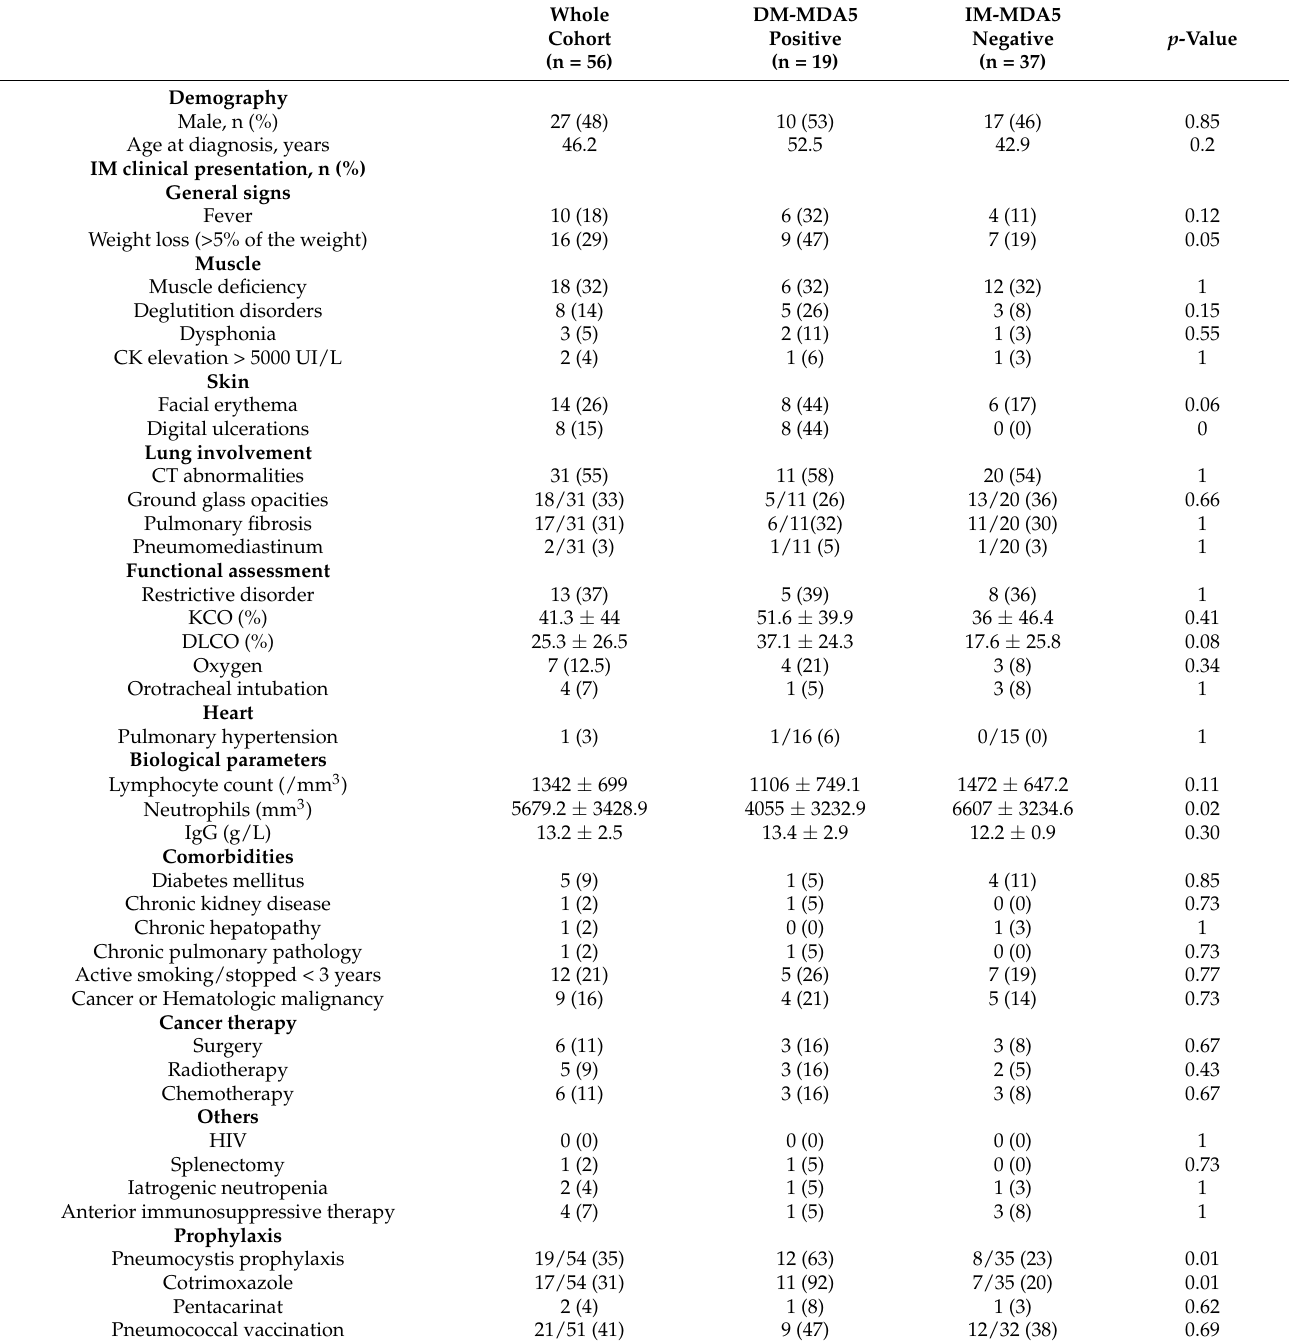
Table 1. Patient characteristics at baseline and underlying immunosuppression (regardless of DM/IM